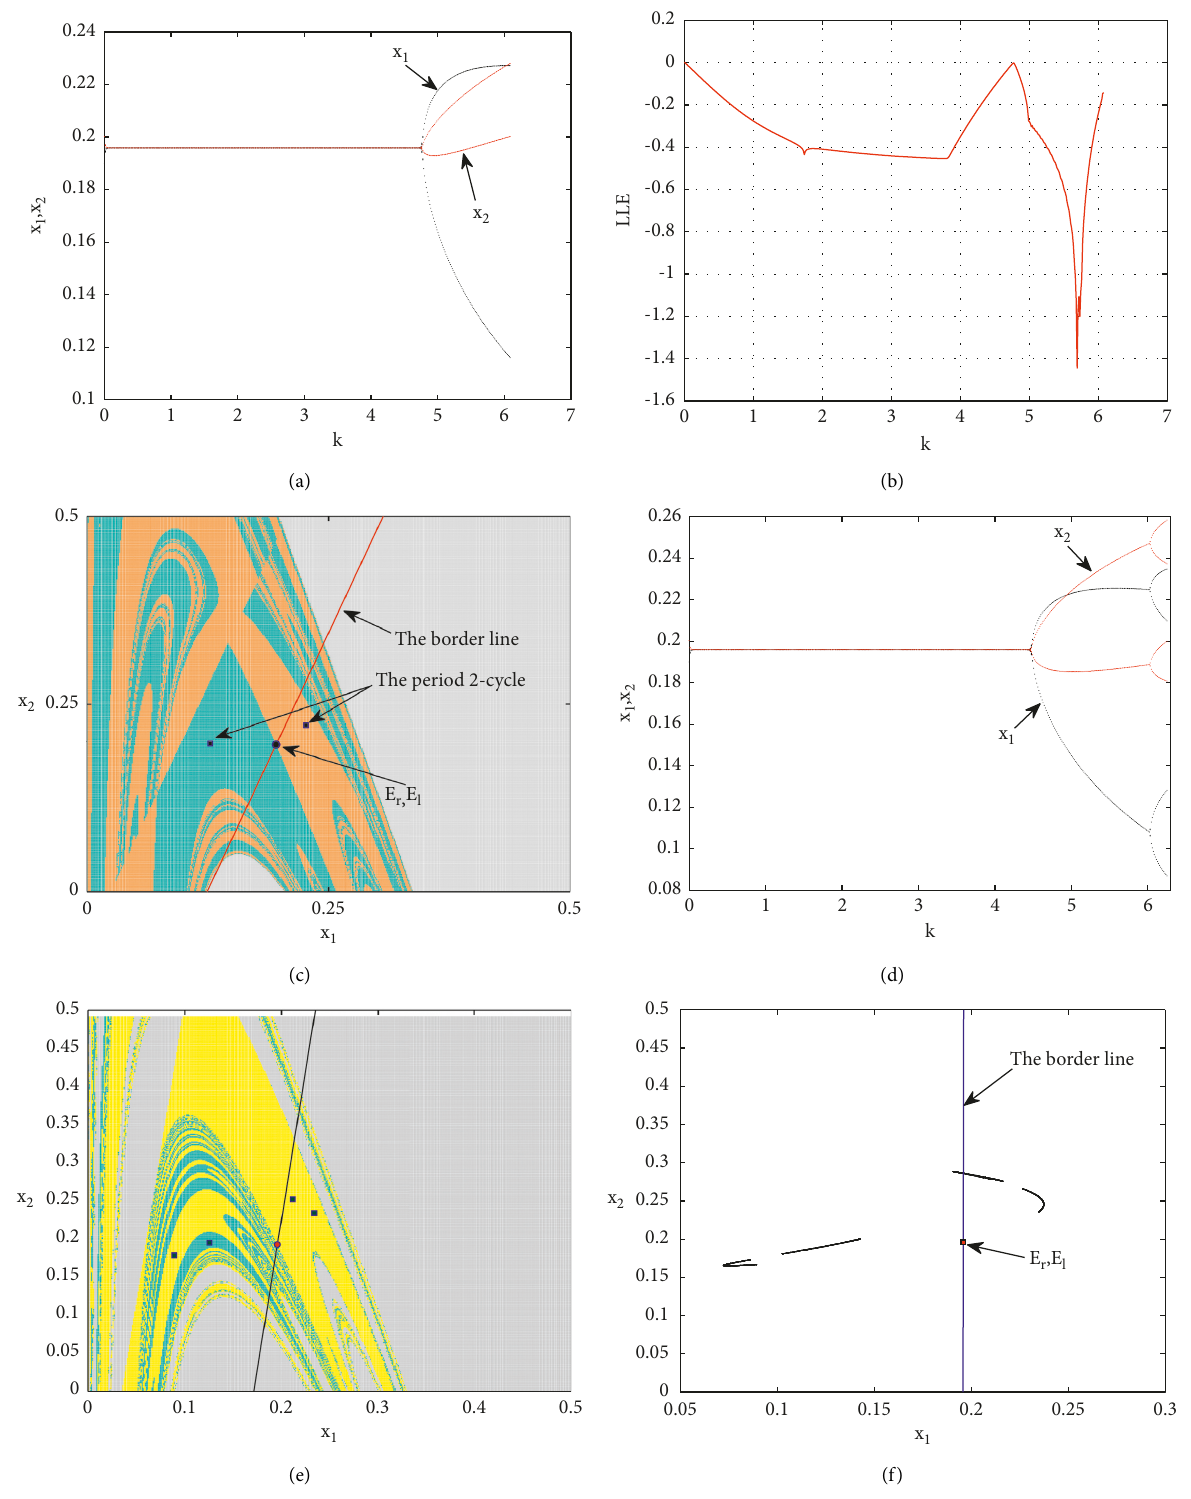
Figure 1: (a) The stable period 2-cycle when varying the parameter k at the parameter values: ω � 0 . 5 , c and β � 0 . 5. (b) Largest Lyapunov exponent corresponds to the bifurcation diagram in Figure 1(a). (c) Basin of attraction of the stable period � 0 . 5 ,c � 0 . 3 , δ � 0 . 5525470489 , β � 0 . 5 and k � 5 . 72. (d) The stable period 2-cycle when varying the parameter k at 2-cycle at ω � 0 . 5 ,c 1 2 � 0 . 5 ,c � 0 . 3 , δ � 0 . 5525470489 and β � 0 . 8. (e) Basin of attraction of the stable period 4-cycle at ω the parameter values: ω � 0 . 5 , c 1 2